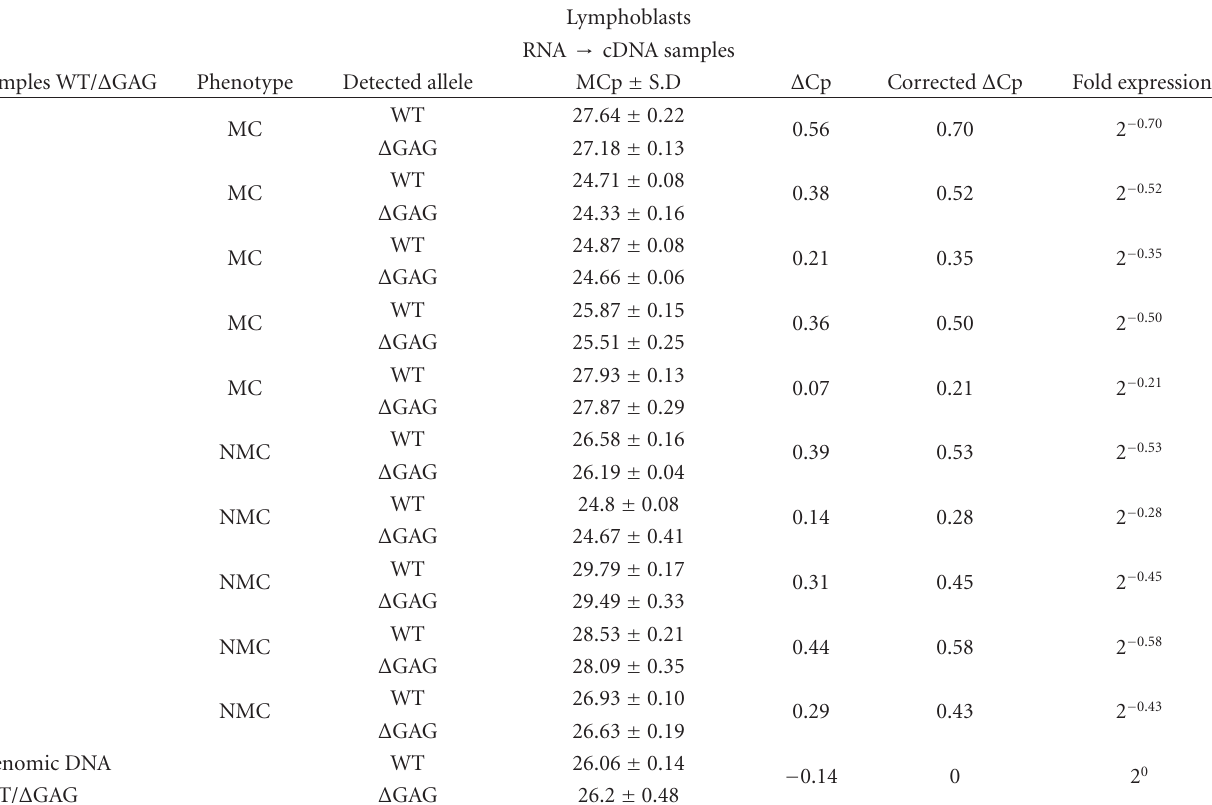
Table 2: Expression ratio of WT to Δ GAG TOR1A in lymphoblasts from MC and NMC. Lymphoblasts RNA → cDNA samples